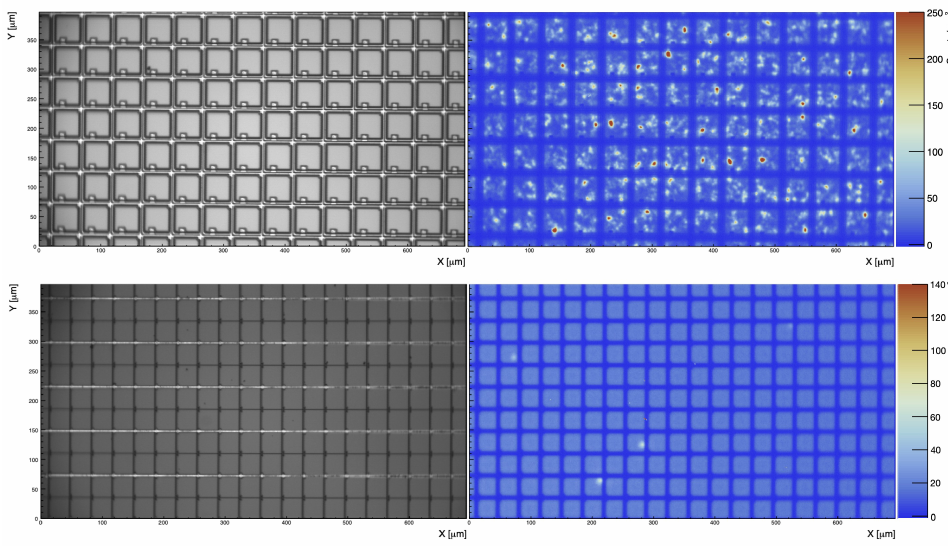
Figure 3. Top row: Emission microscopy image (EMMI) of the HPK VUV4 biased at 11.2 ± 1.0 V of over voltage. Bottom row: EMMI of FBK VUV-HD3 biased at 13 ± 1 V of over voltage. Both EMMIs were taken with the same camera exposure time and objective lens: LMPLFLN20X (20 × magnification).